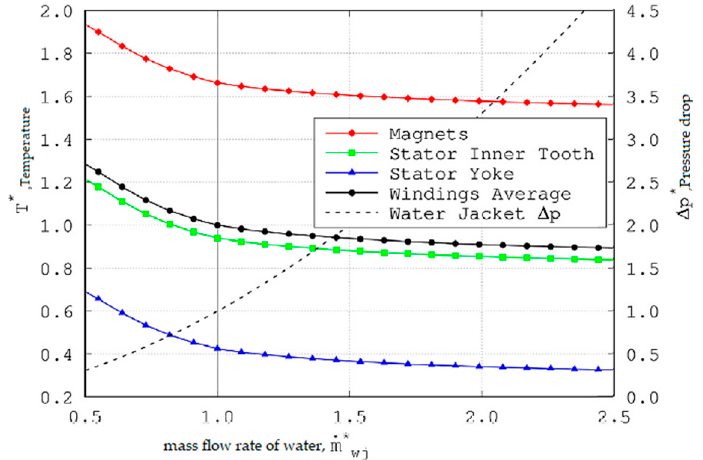
Figure 12. Brushless PMSM and water jacket cooling [14].